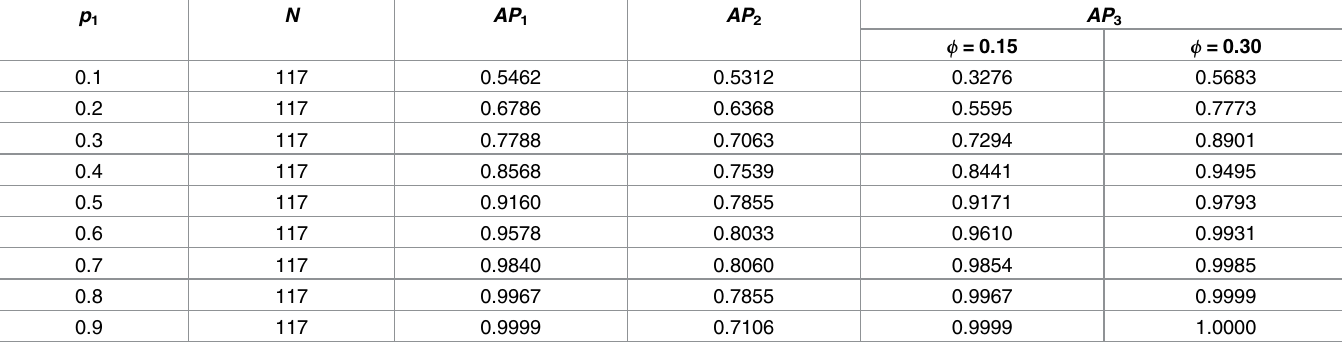
Table 1. Sample size and assurance probabilities for observing criteria (i), (ii), and (iii) given α = 0.025, β = 0.1, ( Δ 1 , Δ 2 ) = (3,0.45), ( σ 1 , σ 2 ) = (6,1), ( γ 1 , γ 2 ) = (0.5, 0.5), and ρ 12 = 0.1.